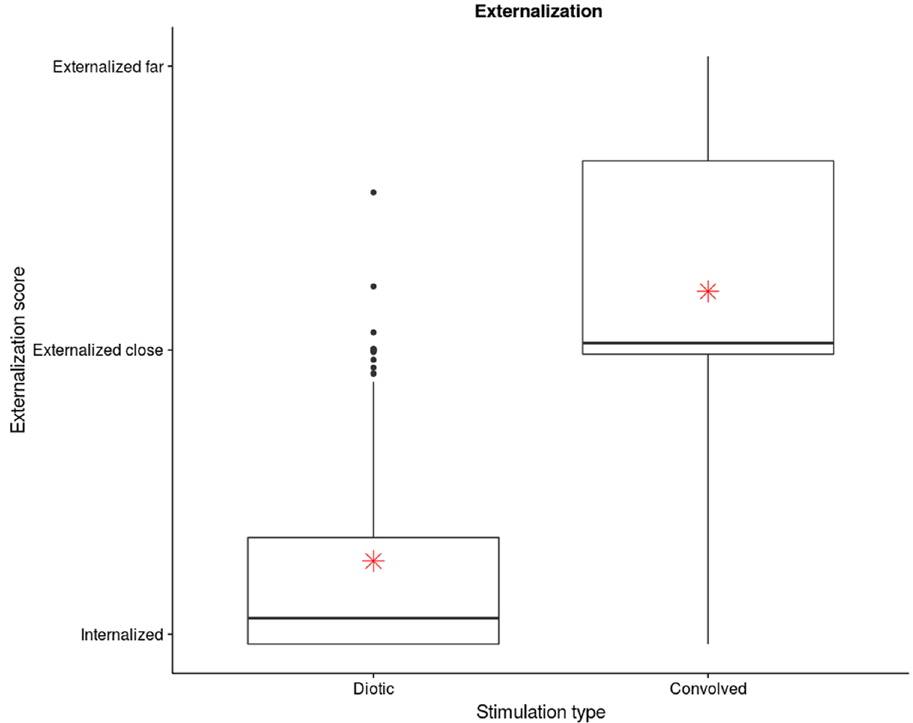
Figure 1. Behavioral evaluation of musical stimuli. Ratings for the subjective assessment of perceived externalization of all musical stimuli. Healthy participants listened again to all musical stimuli heard during the EEG protocol (both convolved and diotic versions), and rated using a slider on a continuous scale where the sound came from. Convolved sounds are generally judged as coming from the external environment, while diotic versions are judged as originating from within the head. Boxplot represents the confidence interval around the median. Star indicates the